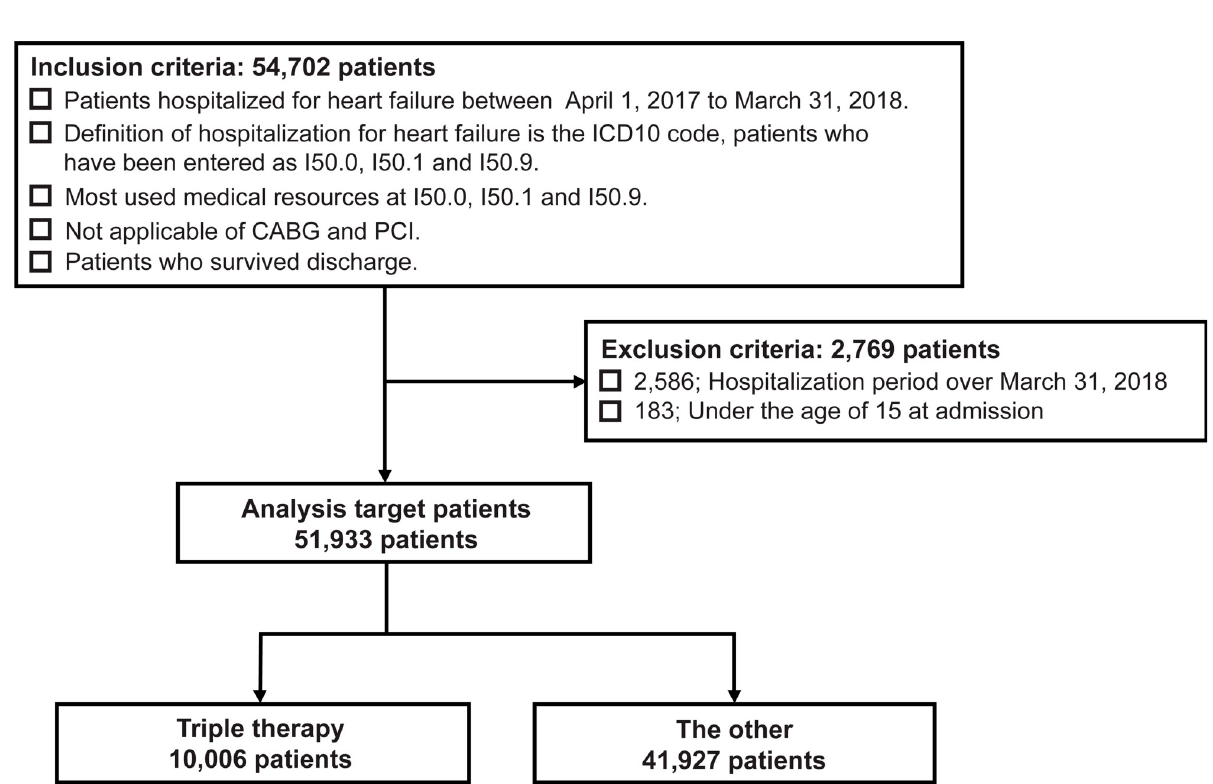
Fig 1. Selection of patients with HF. The triple therapy group received angiotensin-converting enzyme inhibitors (or angiotensin II receptor blockers), β -blockers, and mineralocorticoid receptor antagonists. The other group consisted of the remaining patients who did not receive triple therapy. ICD10: The 10th revision of the International Classification of Diseases and related health problems, CABG: Coronary artery bypass grafting, PCI: Percutaneous coronary intervention.